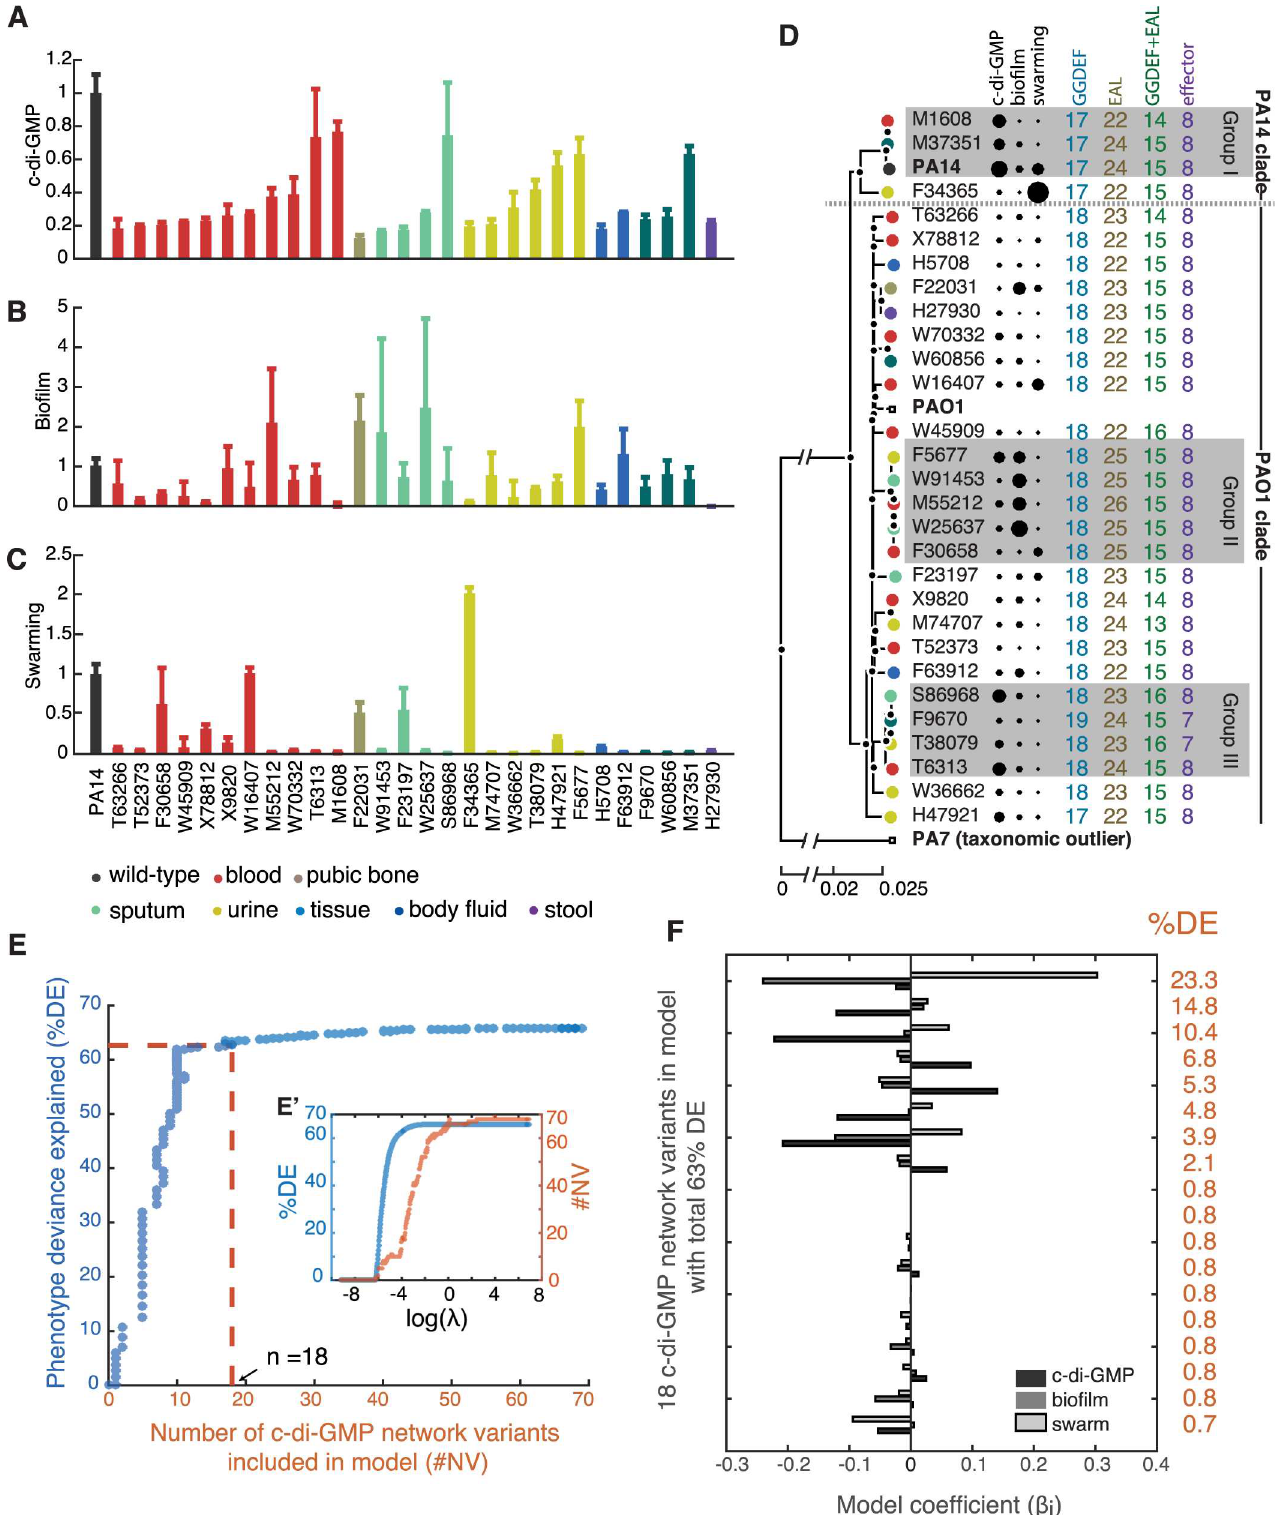
Fig 2. Phenotypic diversity in 28 P . aeruginosa isolates from acutely infected cancer patients at MSKCC explained by many small-effect alleles in c-di-GMP network. A: Bulk c-di-GMP levels collectedfrom bacterial colonies,includingfor the laboratorystrain PA14. B: Biofilm levels